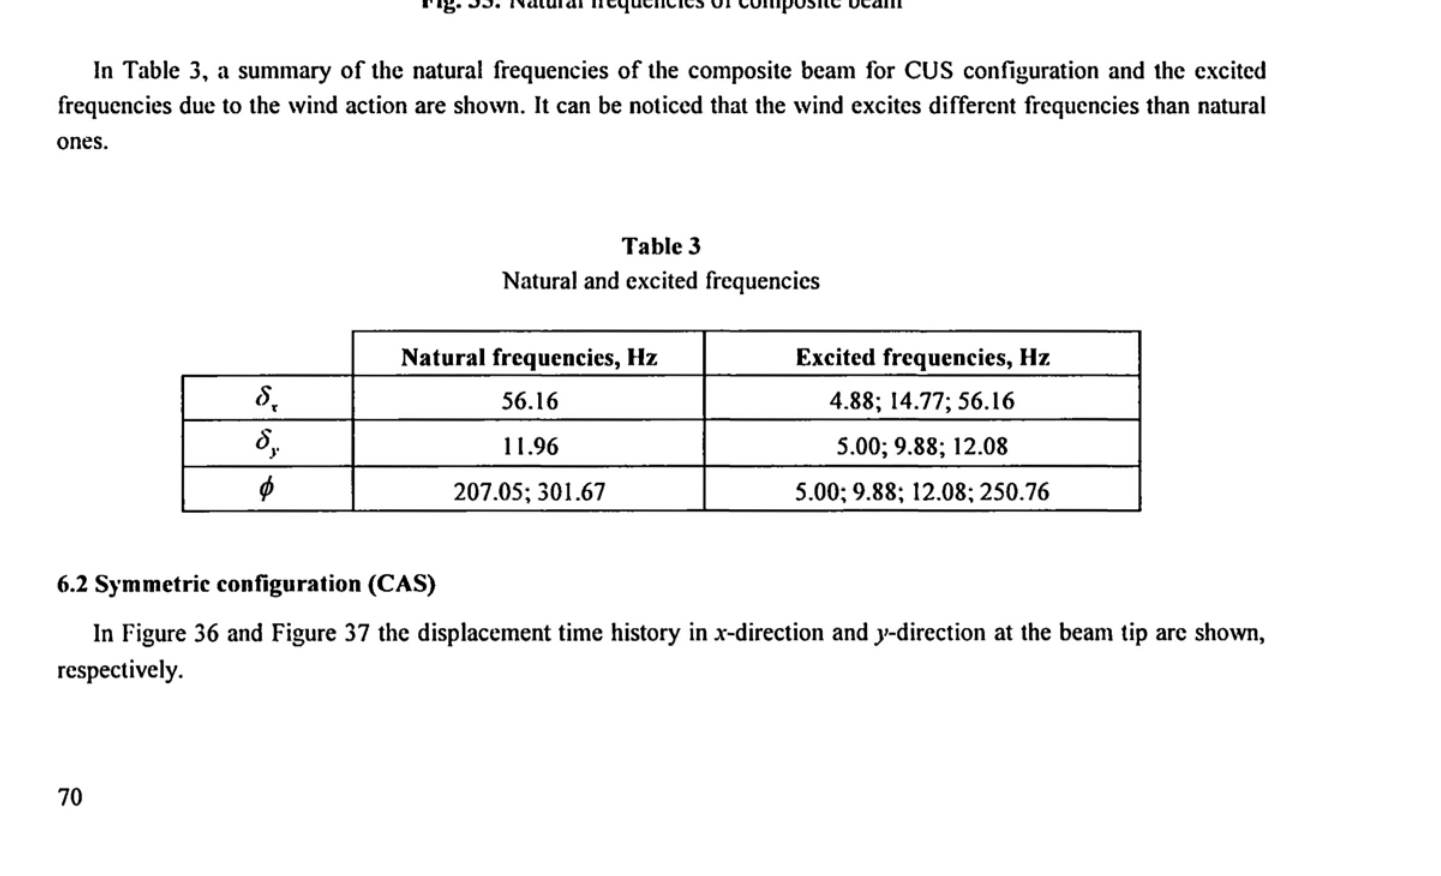
Fig. 35: Natural frequencies of composite